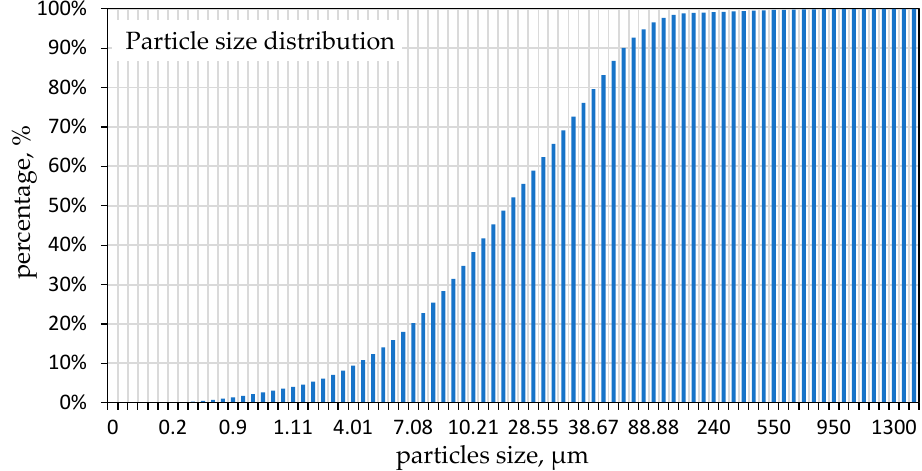
Figure 2. Grain size distribution of the jarosite waste.